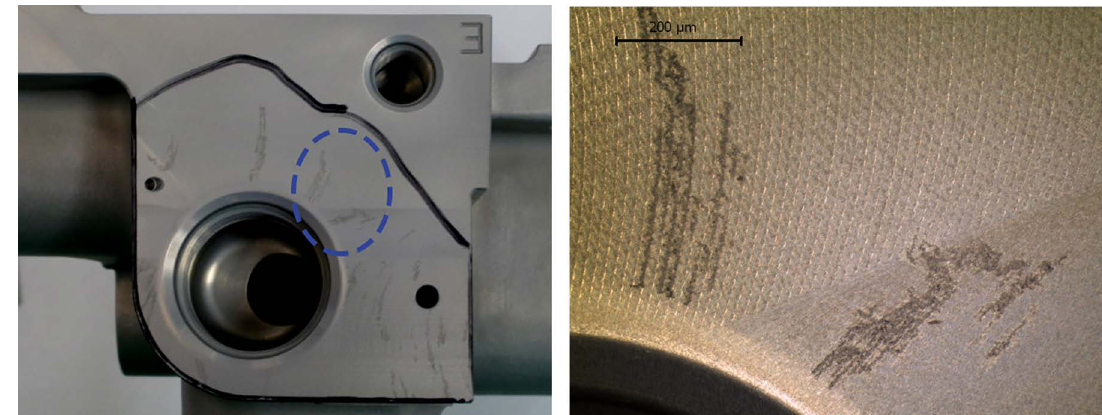
Figure 2. AA7075-T73 machined part presenting corroded areas right after the machining step